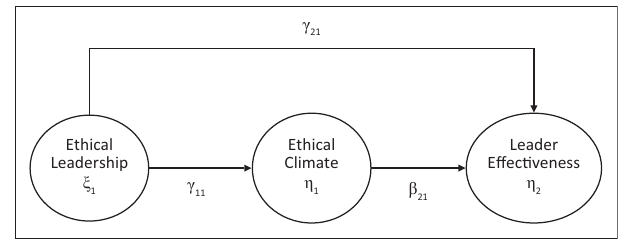
FIGURE 1: The structural model representing the relationships between ethical leadership, ethical climate and perceived leader